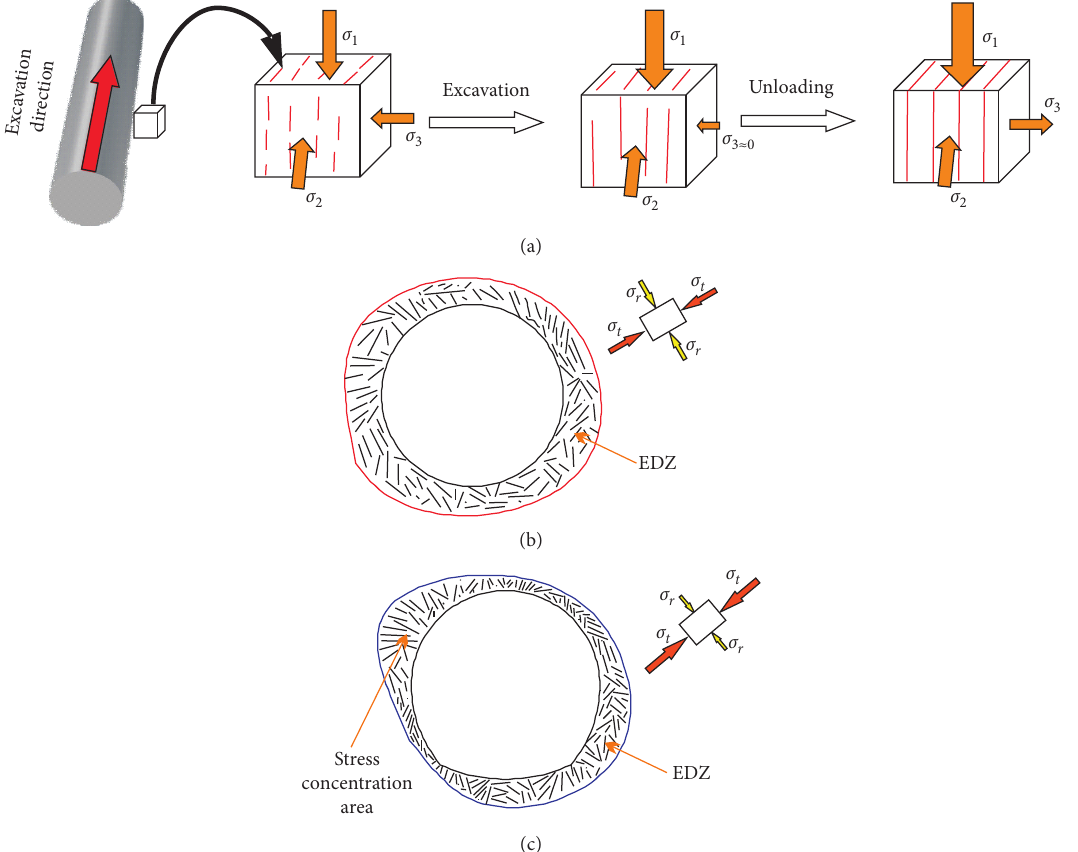
Figure 7: Unloading failure mechanism by different excavation methods: (a) unloading and failure process during the excavation, (b) the EDZ induced by the TBM, and (c) the EDZ induced by